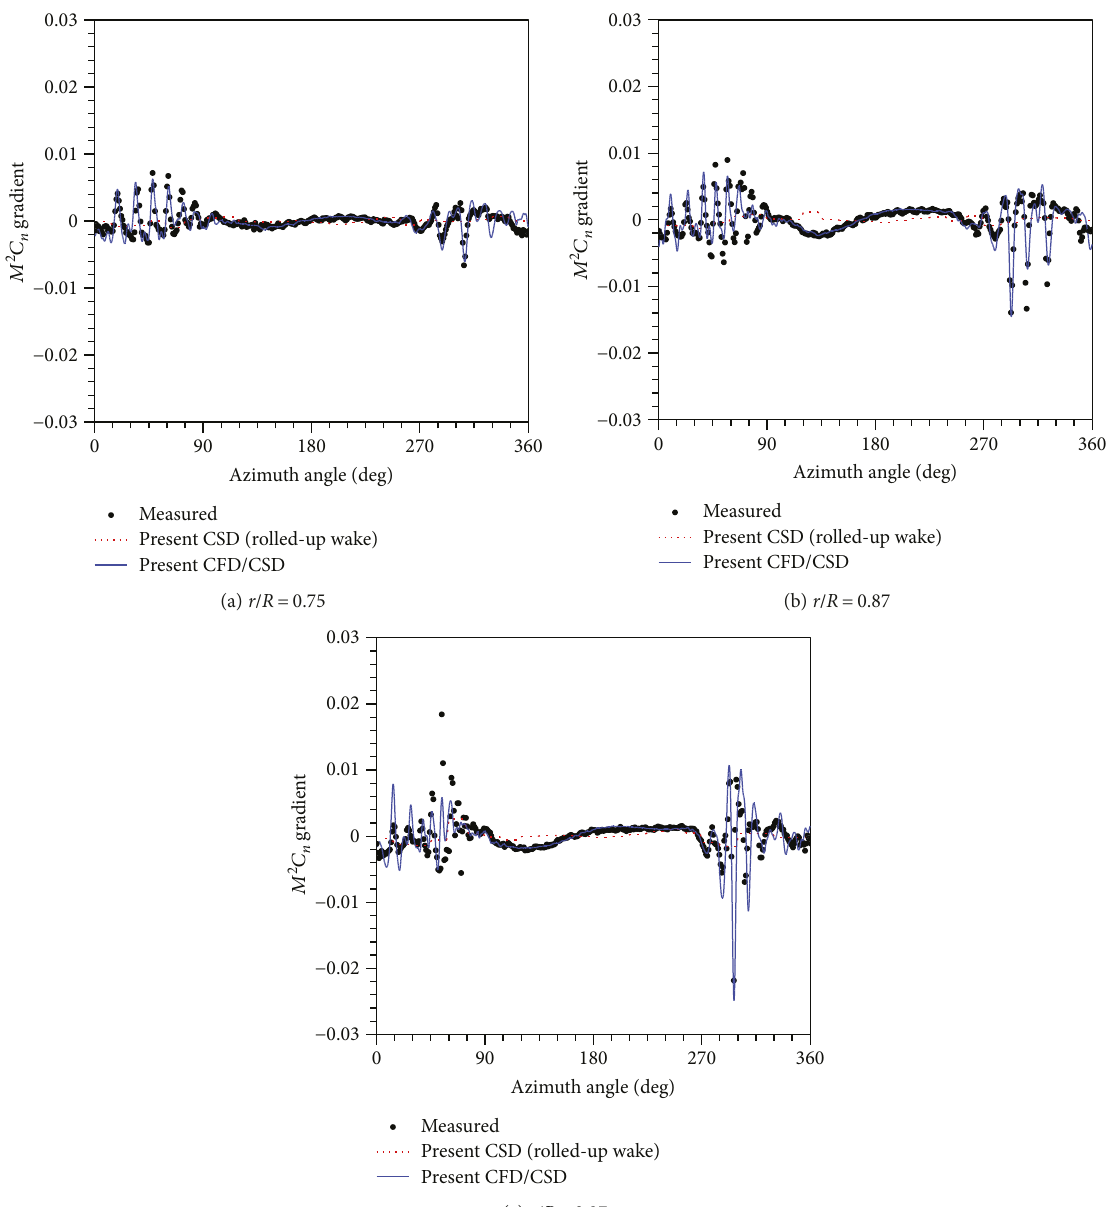
/ d ψ with radial n